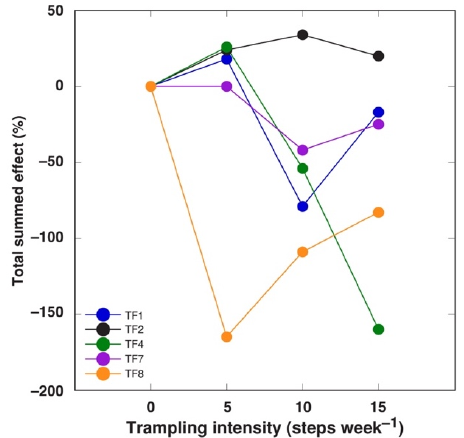
Figure 6. Total summed effect of increasing trampling intensity on morphology and biomass of Trifolium fragiferum plants of different accessions. Measurements were performed after five weeks of treatment plus three weeks of recovery. Only statistically significant effects are taken into the account.